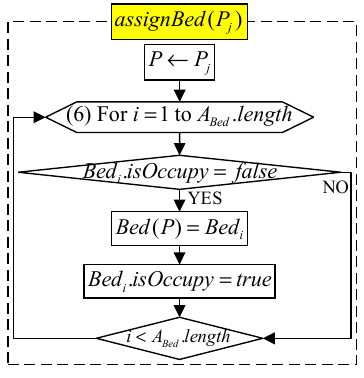
Figure 17. Flow chart for arranging beds.